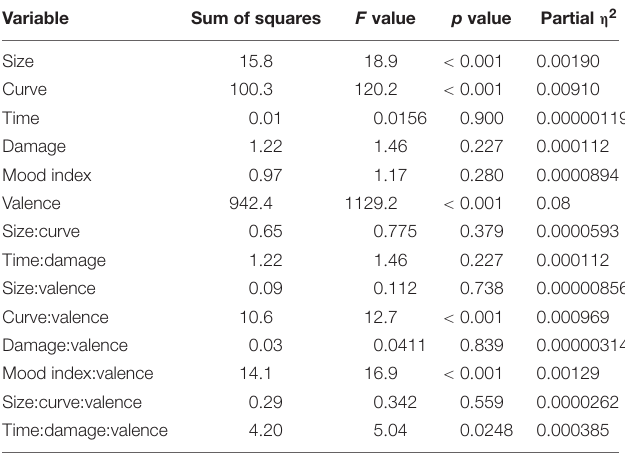
TABLE 2 | Type III analysis of variance with Satterthwaite’s method for the linear mixed-effects (LME) model. Variable